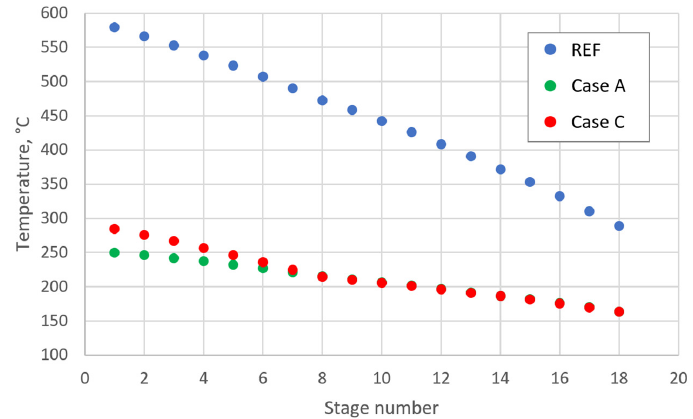
Figure 4. Temperature distribution calculation in the IP section of the turbine.